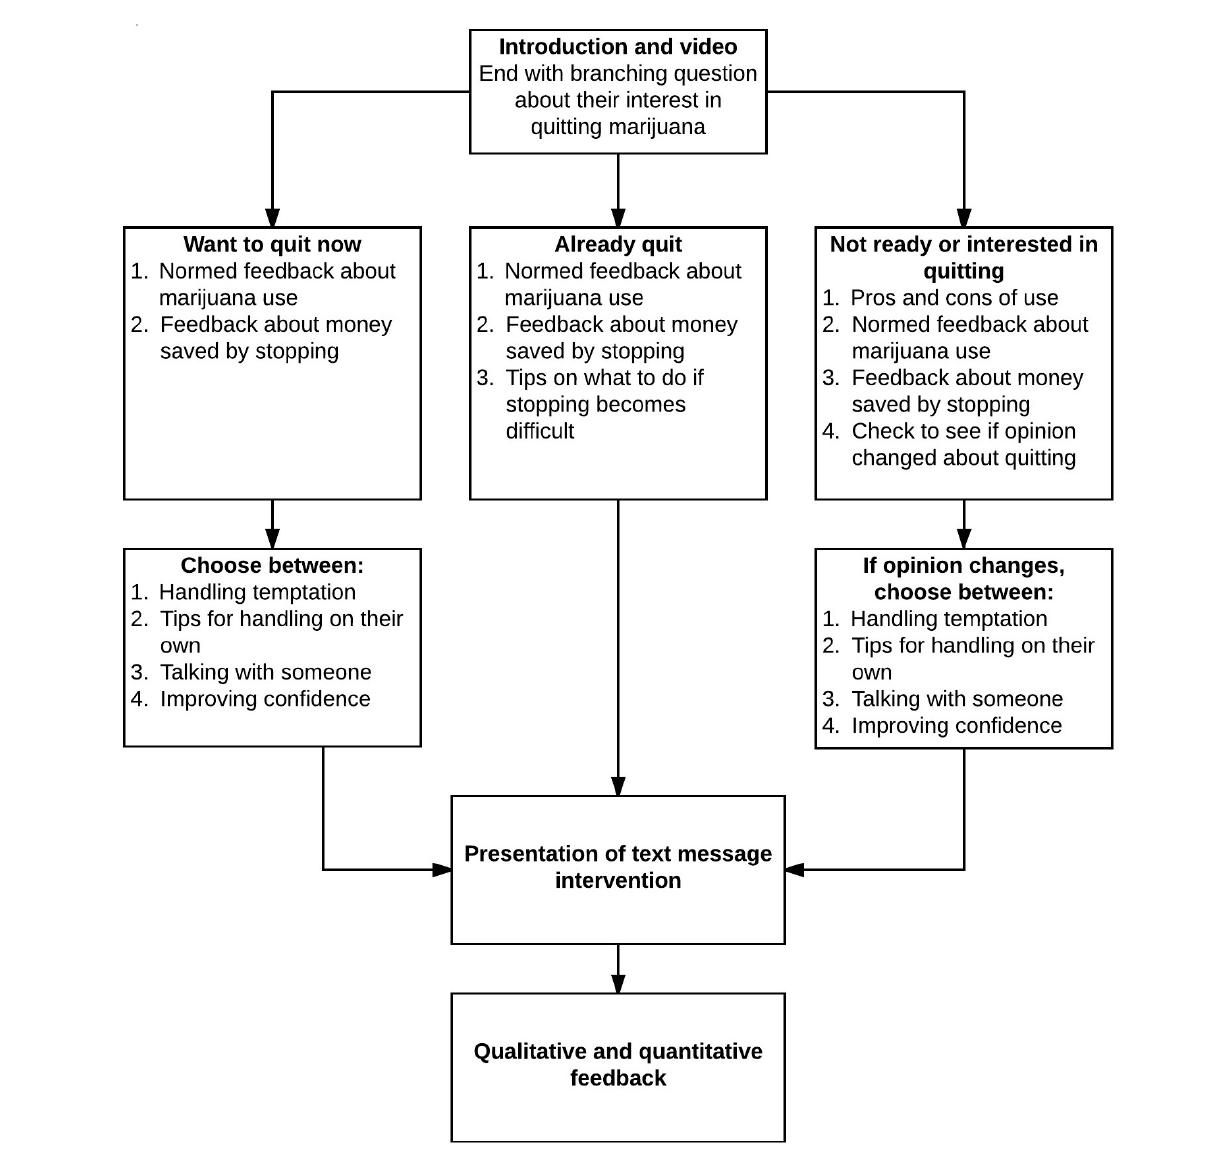
Figure 1. Intervention